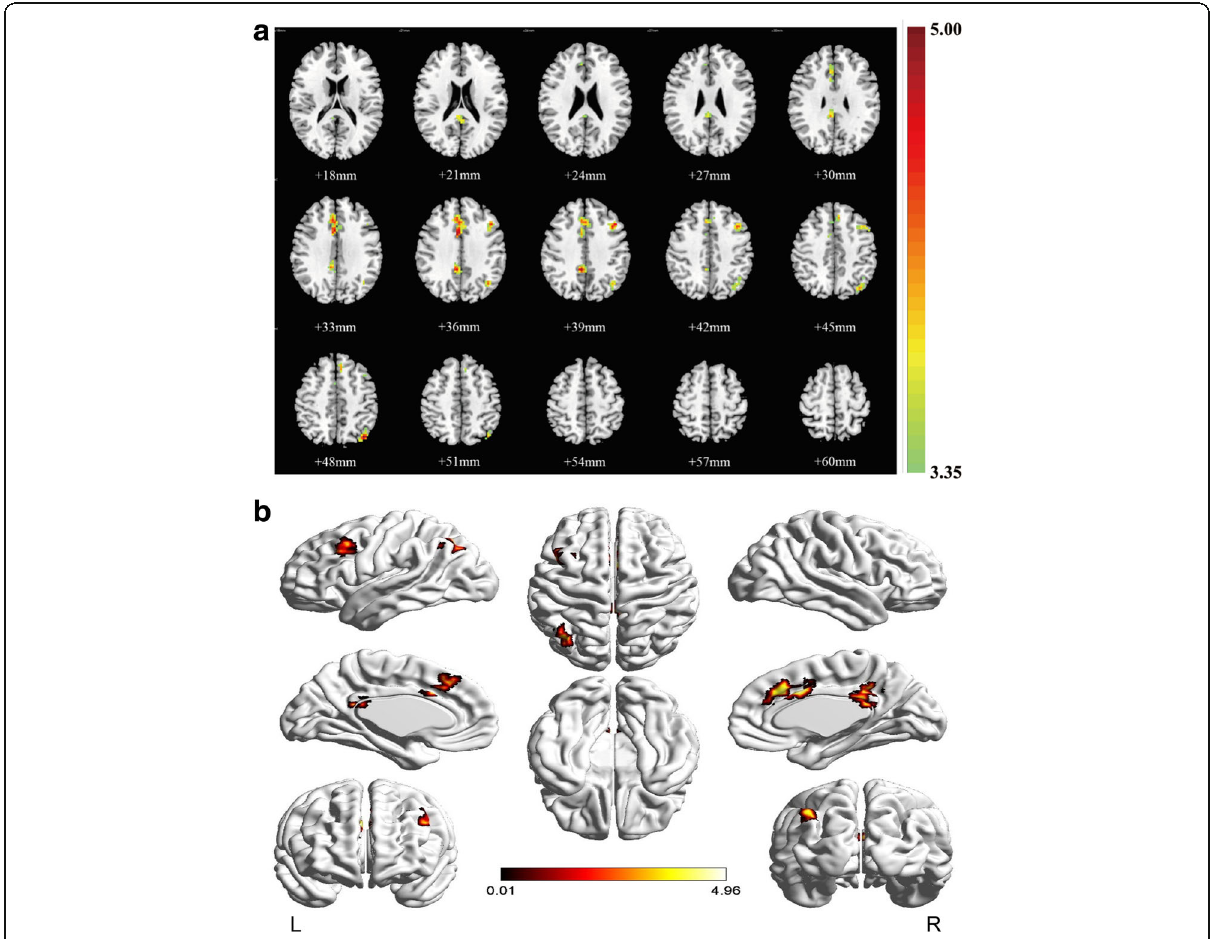
Fig. 1 ROI-whole brain analysis of FCs between the 12 insular subdivisions and the whole brain (visualization of the clusters on the brain surface). The warm color in the statistical differences map indicated the increased FCs between the dId_L and the whole brain in males. dId, dorsal dysgranular insula; L, left; R, right; FCs, functional connectivities; ROI, region of